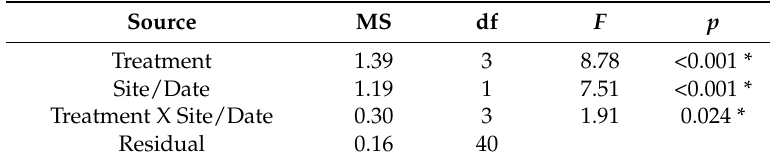
Table 6. Two-way PERMANOVA comparing the composition of interstitial invertebrate assemblages across Patch Types ( Porphyra covered vs. Exposed mussel bed areas) and experimental Sites/Dates (Punta Cantera/2011, Las Brusquitas/2015, and Copacabana/2017). Asterisks indicate significant effects.